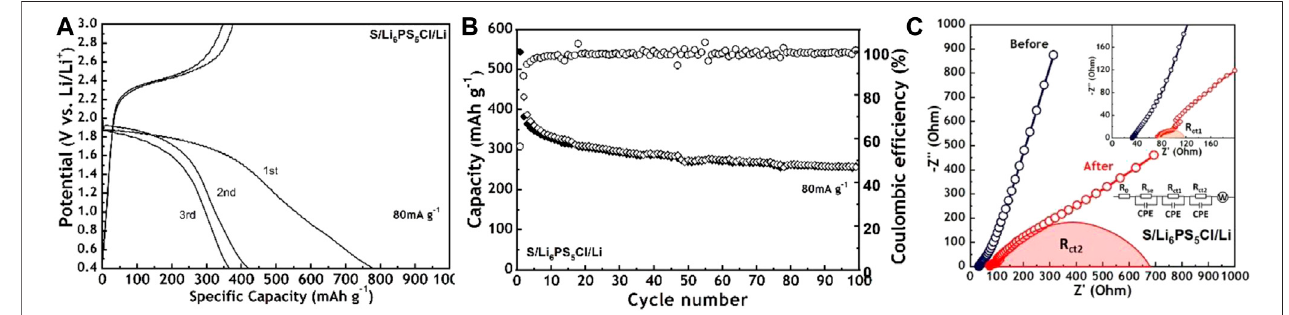
FIGURE4|(A) Charge-dischargepro fi lesduringthe fi rstthreescyclesand (B) cyclingperformanceofS/Li 6 PS 5 Cl/Licellat80 mA g − 1 and30 ° C (C) Nyquistplotsof S/Li 6 PS 5 Cl/Li cell before cycling and after 100 cycles at 80 mA g − 1